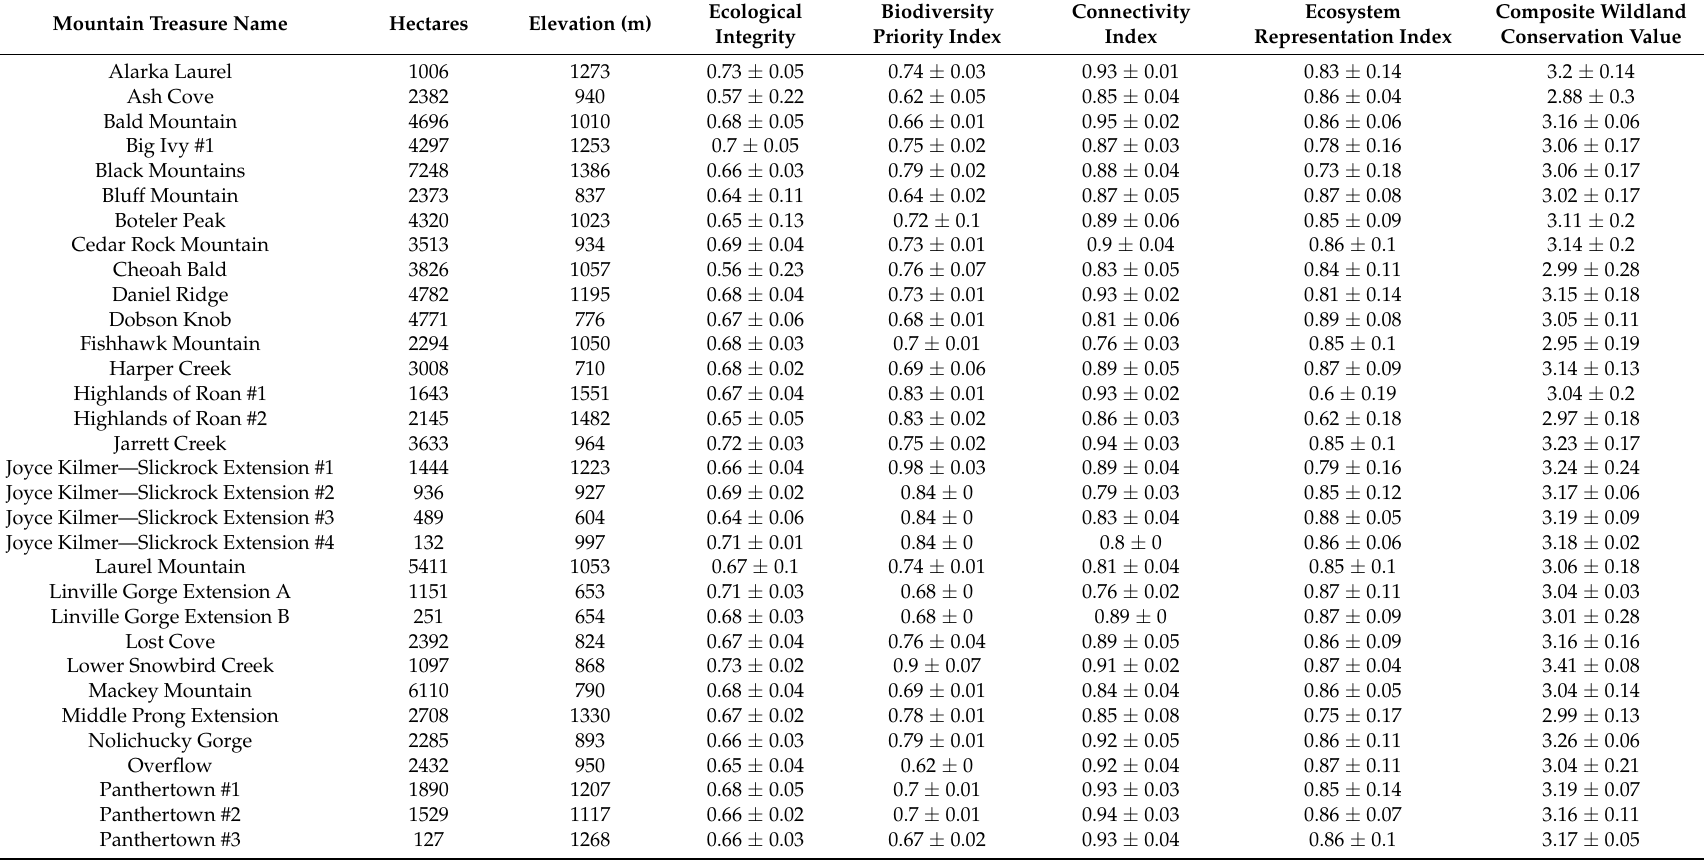
Table A1. List of North Carolina’s Mountain Treasures, area, mean elevation (meters above sea level), and mean indices ( ± standard deviation) based on the national data of Belote et al.